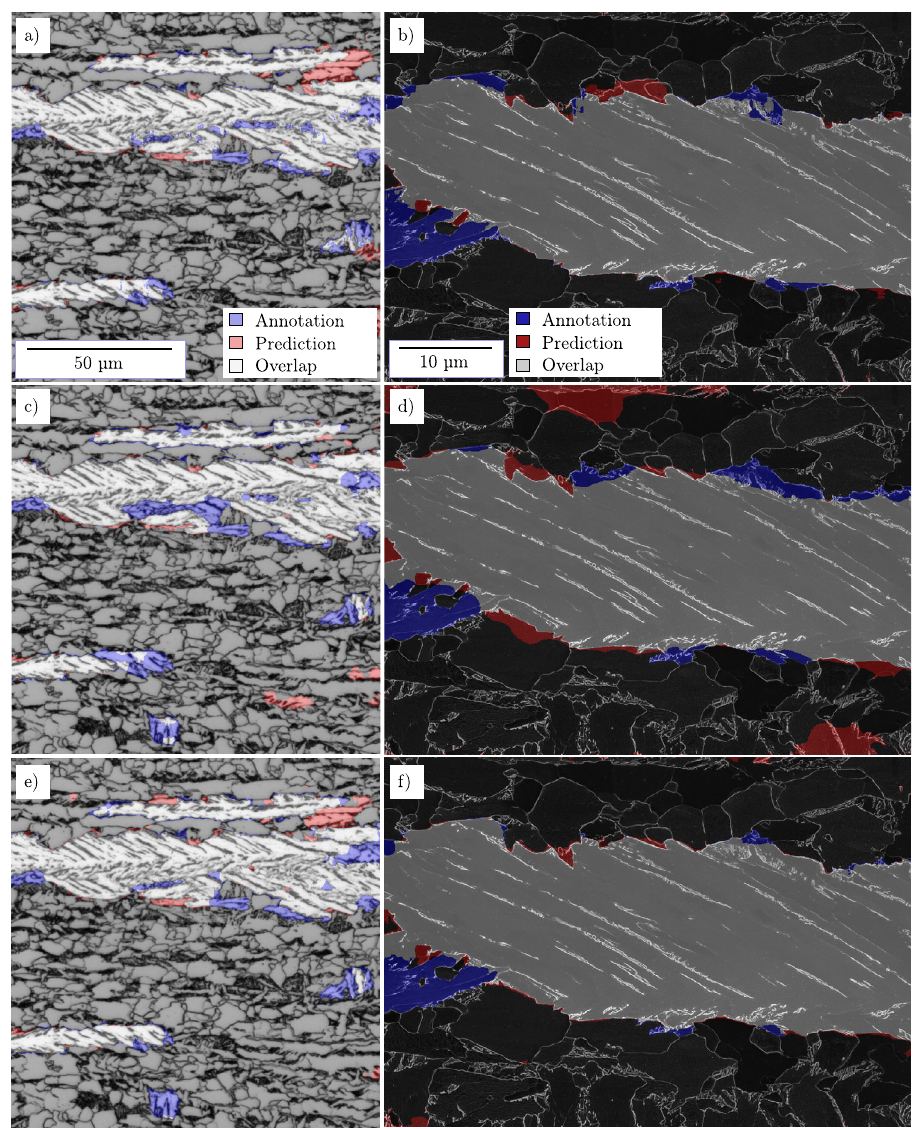
Fig. 3 Light optical and scanning electron micrographs superimposed with lath-bainite predictions of different models and annotated regions showing the comparison between model prediction (red) and manual expert annotation (blue). a , b Random initialized vanilla U-Net (model #1 and #6). c , d Random initialized U-Net VGG16 (model #3 v and #8 v ). e , f Pre-trained U-Net VGG16 (model #3 and